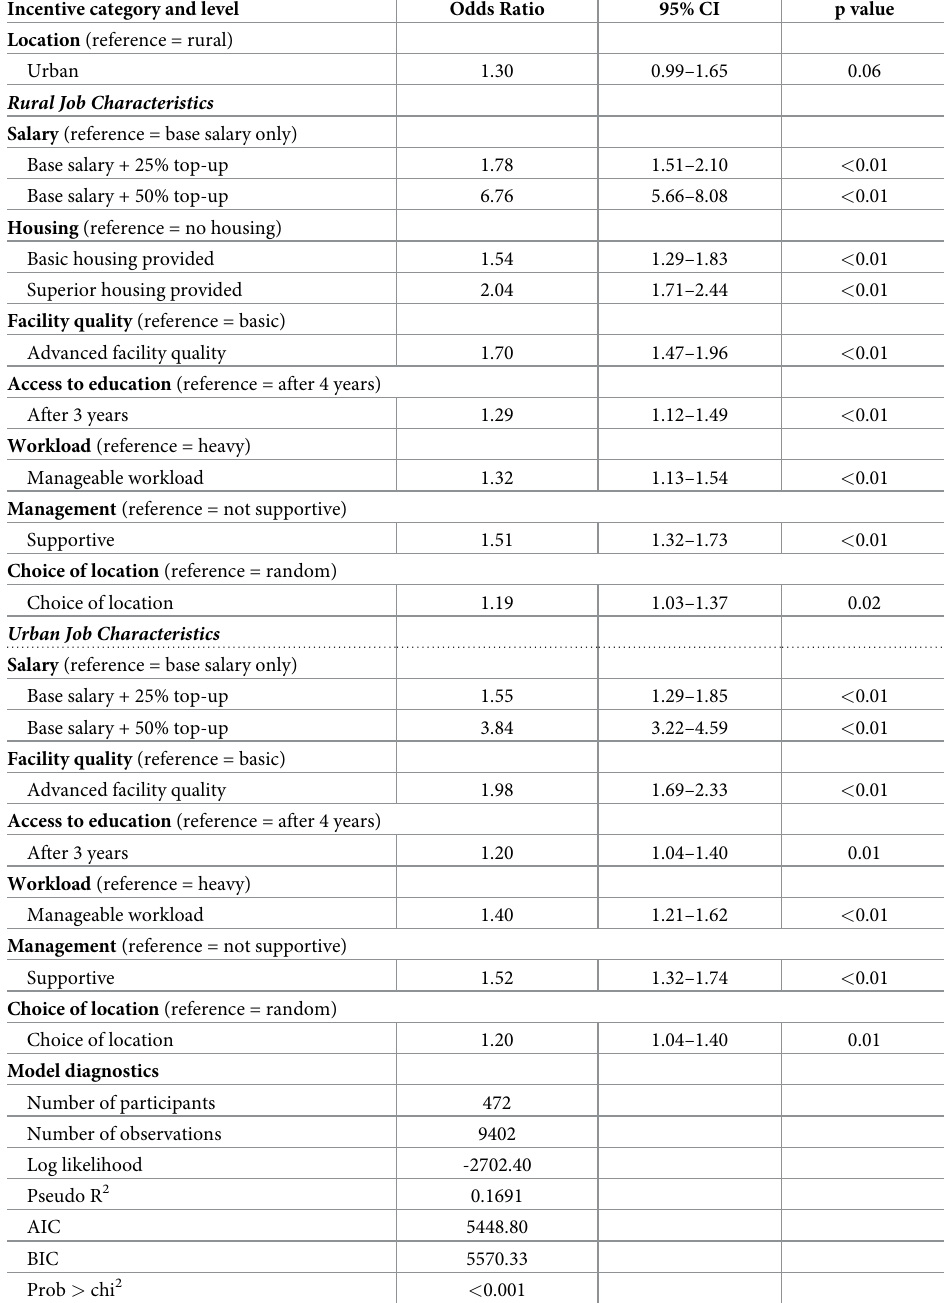
Table 4. Determinants of job